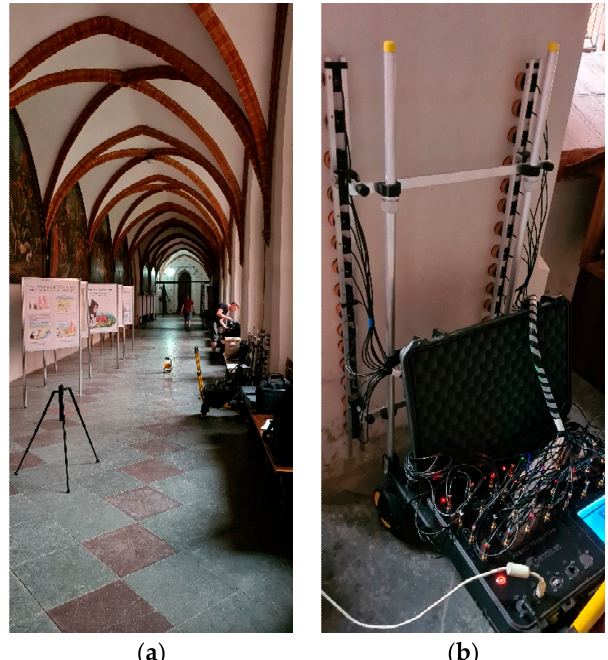
Figure 6. The interior of the Cistercian abbey in Pelplin: ( a ) the cloisters; ( b ) EIT measurement station.